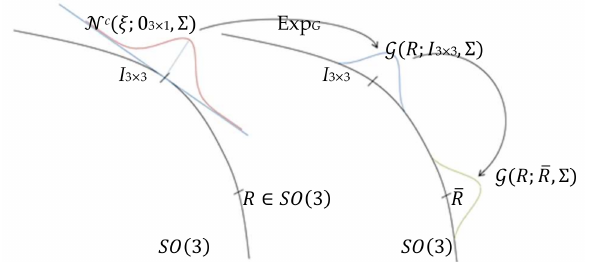
Figure 2. The mappings between the probability definition for Lie group rotation matrix R ∈ SO ( 3 ) and the classical Gaussian distribution vector w ∈ R 3